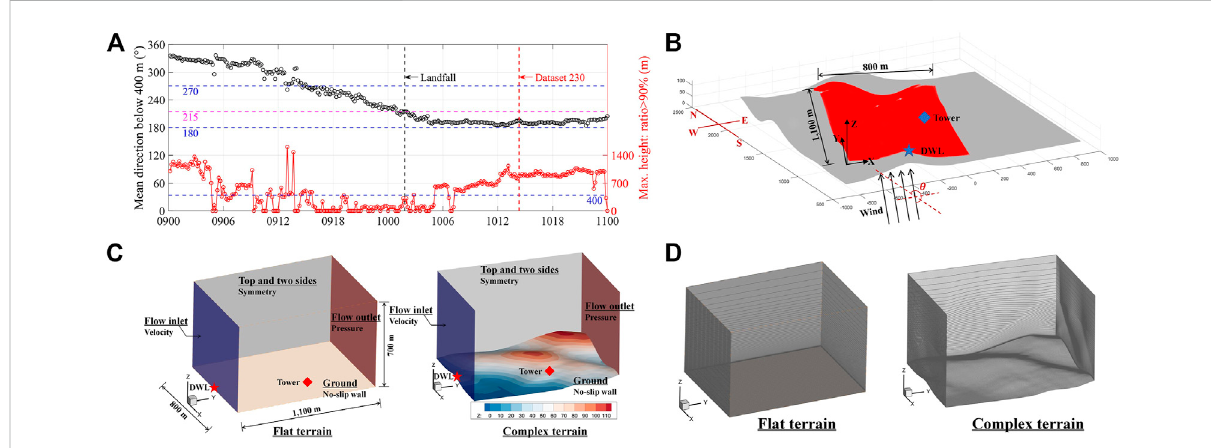
FIGURE 10 Setup of CFD simulation: (A) Time evolution ofmean wind direction below 400 m (vertical axis on the left) and the maximum height associated with data quality ratio exceeding 90% (vertical axis on the right); (B) Schematic diagram of computational domain, and the grey color represents the largerregionof2 km×2 kmterritorywithgridsalonglatitudeandlongitude,andtheredcolorrepresentsthedeterminedcomputationaldomain; (C) Schematicdiagramofnumericalmodelswithboundaryconditionsforboth fl atandcomplexterrains; (D) Schematicdiagramofnumericalgrids for the two